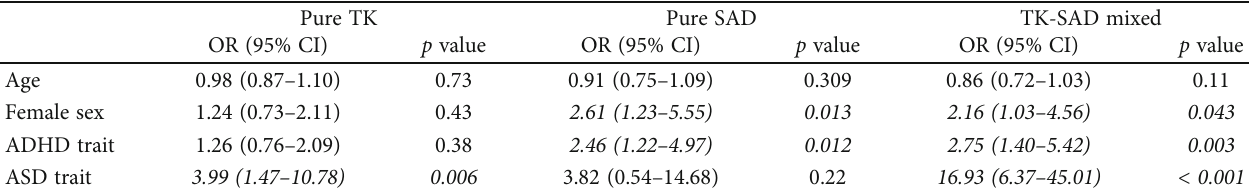
Table 4: Factors associated with pure TK, pure SAD, and TK-SAD mixed on logistic regression